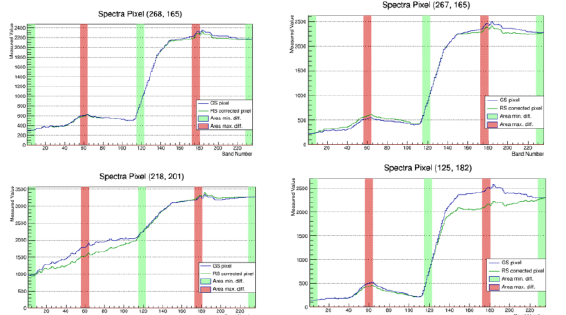
Figure 7. Simulated GS (blue line) and RSC spectra (green line) of four different 30m × 30m DESIS pixels exhibiting different CD values. The pixels have been selected to show increasing GS-RSC difference levels from top-left to bottom-right.